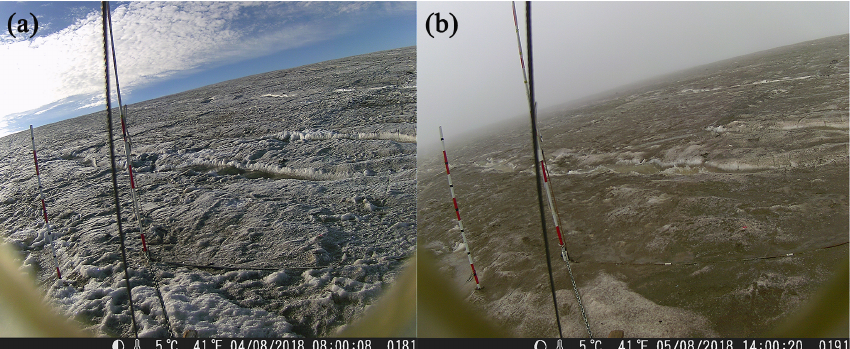
Figure 9. Ice surface overview at the automatic photogrammetry site before and after a strong rainfall event captured by an automatic digital infrared hunting video camera: (a) photograph taken before the rainfall event on 4 August of 2018 and (b) photograph taken after the strong rainfall event on 5 August of 2018.